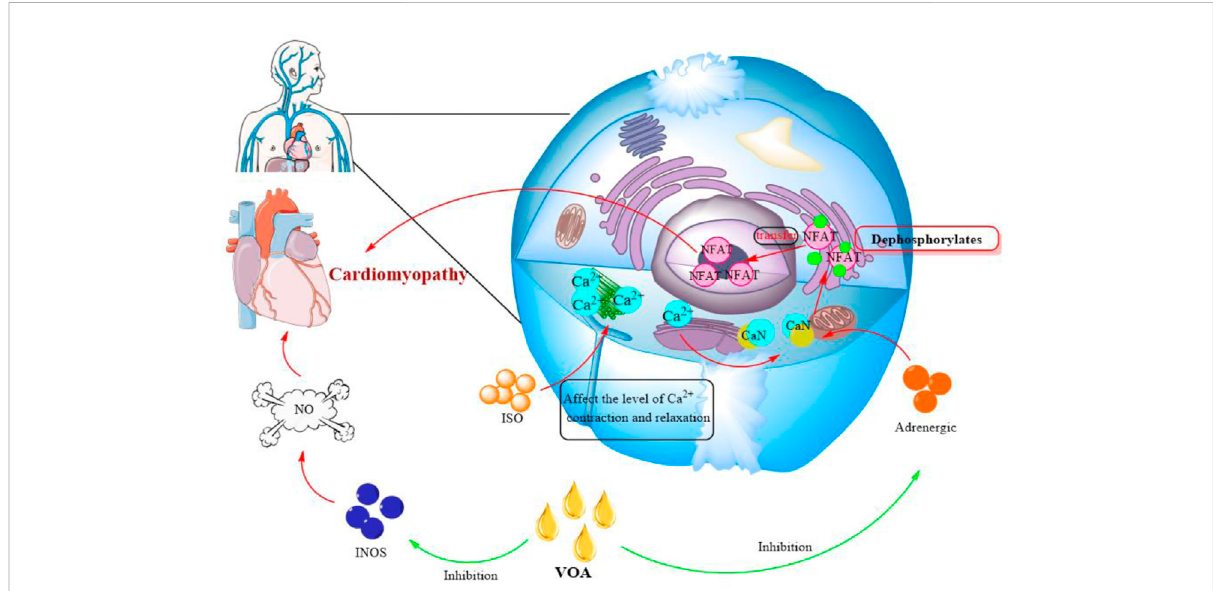
FIGURE 5 Effect of VOA on cardiomyopathy. Red, the mechanism of cardiomyopathy; Green, the effect of VOA on cardiomyopathy. INOS, NO synthase; NFAT, the nuclear factor of activated T cells; ISO, isoproterenol.